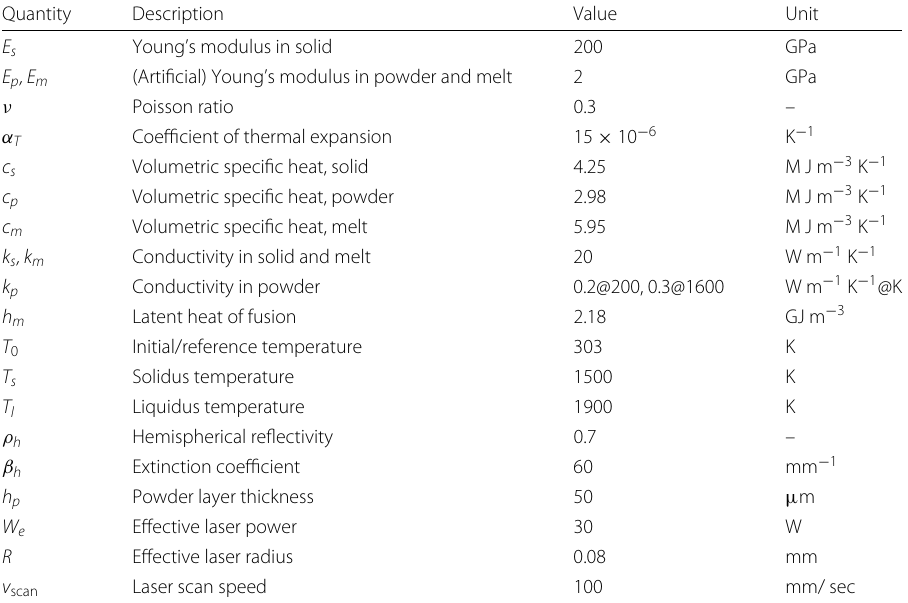
Table 2 Material and simulation parameters for three-dimensional